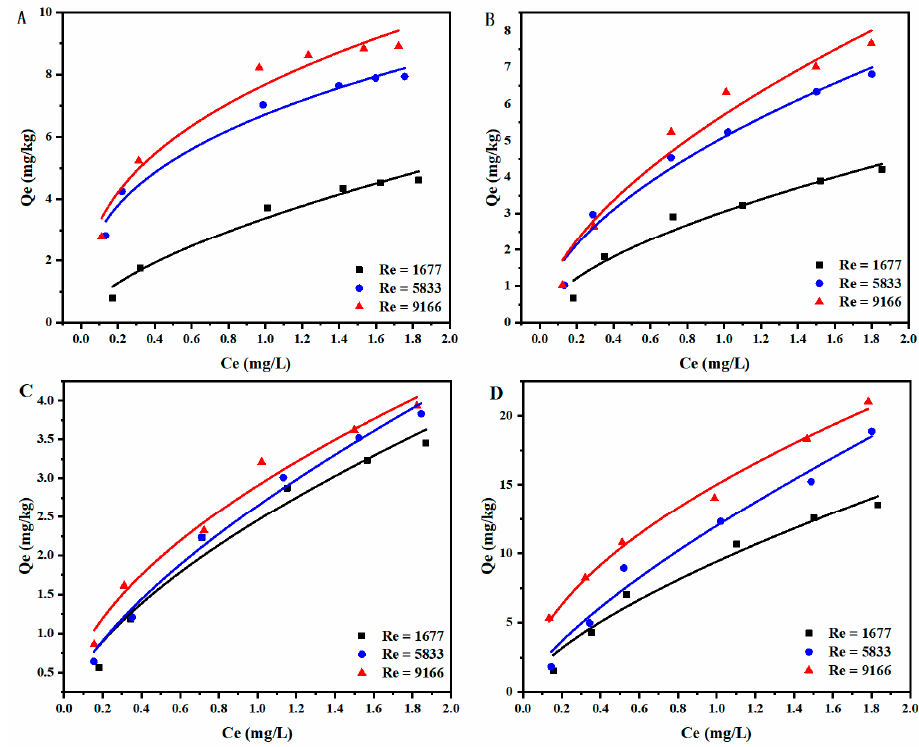
Figure 5. Relationship between equilibrium concentration and adsorption capacity with Freundlich model fitting under different hydrodynamic conditions on ( A ) 2–3 mm quartz sand, ( B ) 250–425 µ m quartz sand, and ( C ) montmorillonite. ( D ) Sediment sample.